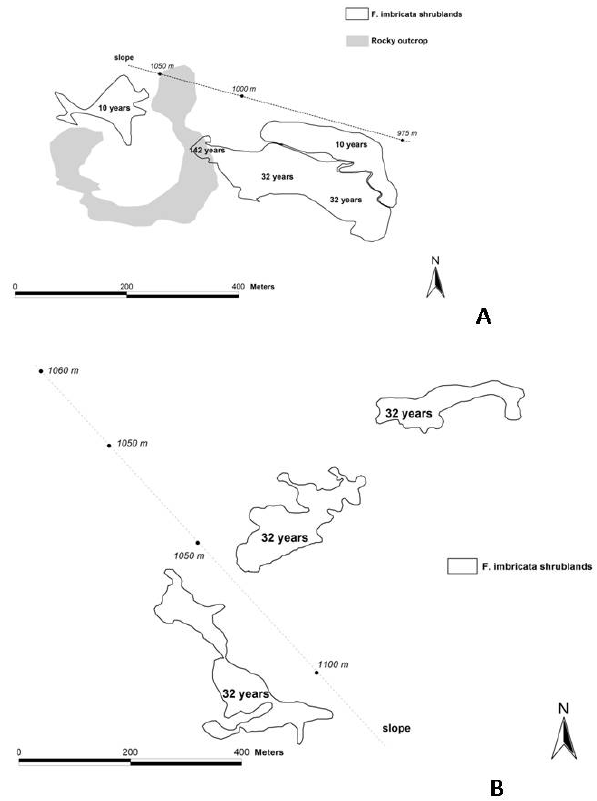
Fig. 5. Spatial distribution of shrubs ages in both study sites. (A) . Fire site. (B) Control